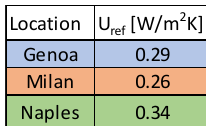
Figure 7. Thermal transmittance in stone walls with different heat reflective insulating layers. The red, blue, and green lines represent the threshold for different cities. More generally, all the configurations concerning the inner insulation determined an increase in the wall thickness of about 6 cm, and accounted for finishes such as plas- ters and drywalls. This in turn implies a not negligible reduction in the useful surface of